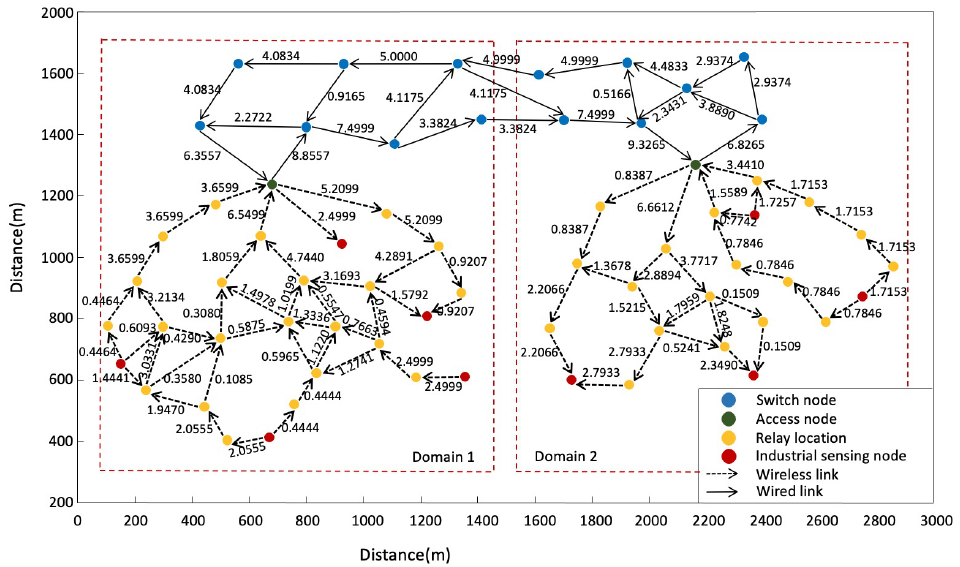
Figure 4. Optimal routing and flow control for cross-domain communication.